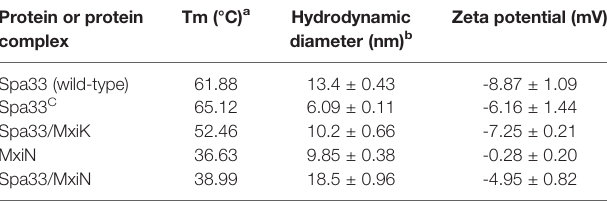
TABLE 3 | Biophysical properties of Spa33, Spa33-containing complexes and MxiN.